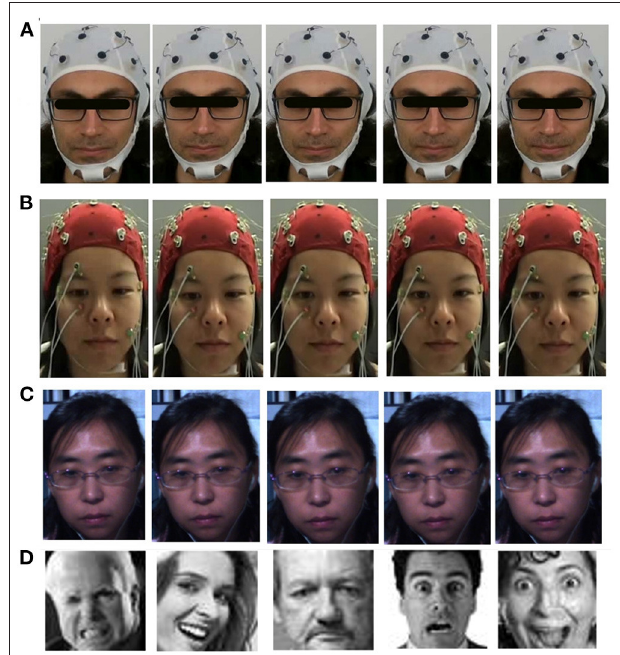
FIGURE 4 | Six frames of a trial of three different datasets from a watching video task. (A) Our dataset, micro-expressions in eyes and lips, (B) DEAP, micro-expressions around lips, (C) SMIC, micro-expressions on the forehead around the eyebrows, (D) FER2013, macro-expressions.